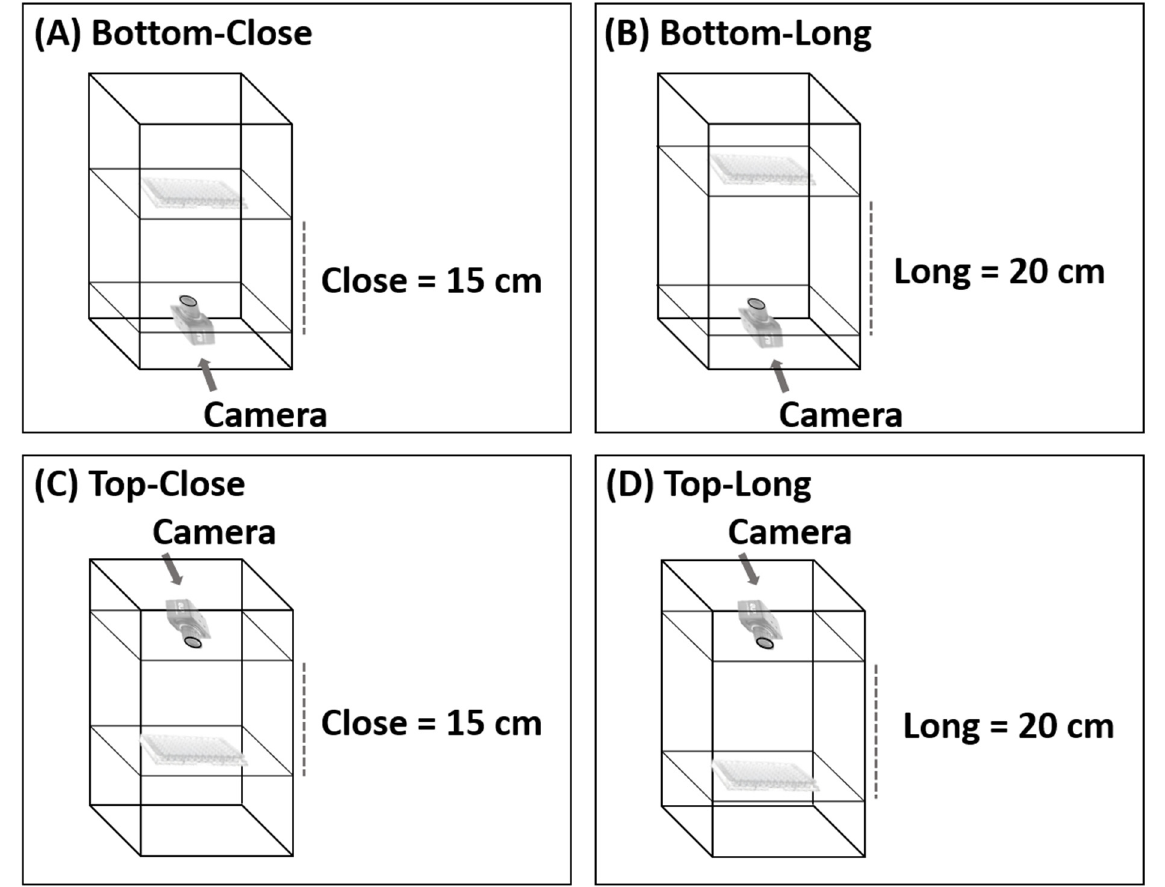
Figure 2. Various configurations of the photographic system; ( A ) Bottom ‐ Close, ( B ) Bottom ‐ Long, ( C ) Top ‐ Close and ( D ) Top ‐ Long.